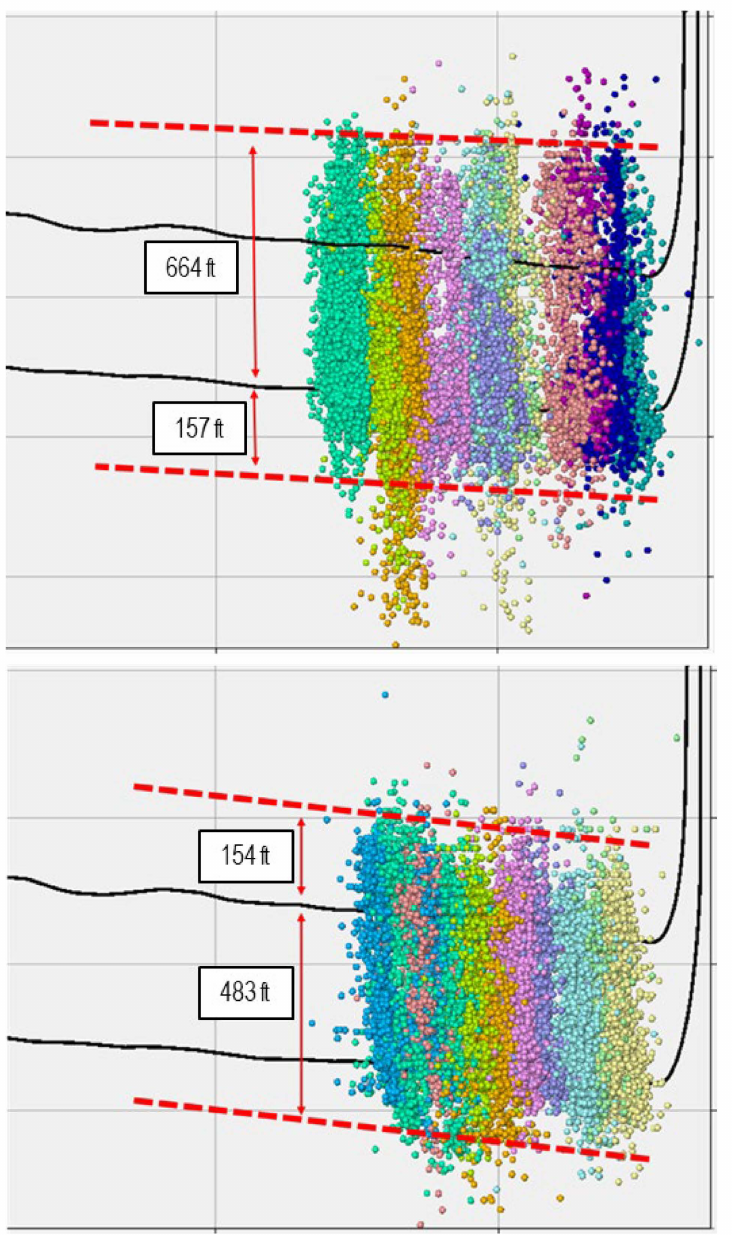
Figure 18. Microseismic event for height estimation. The upper figure shows the height from Well #1 and the lower figure shows the height from Well